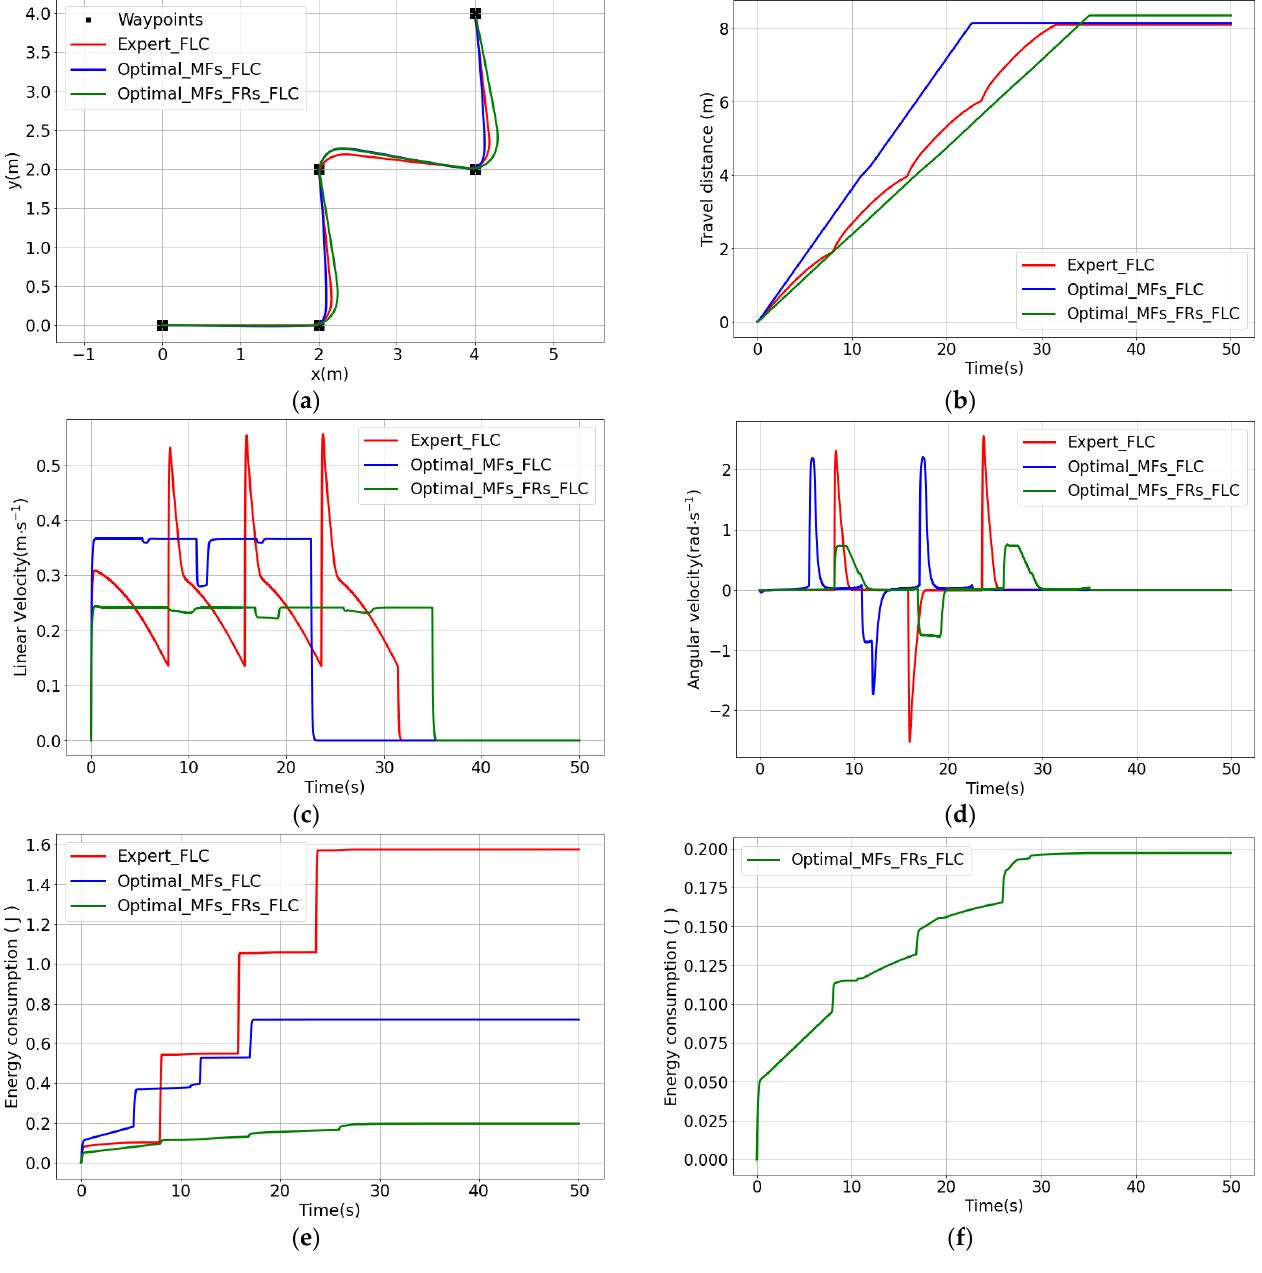
Figure 15. The simulation results in the case of using the zigzag path. ( a ) The trajectory of the robot; ( b ) The robot’s travel distance over time; ( c ) The robot’s linear velocity over time; ( d ) The robot’s angular velocity over time; ( e ) The robot’s kinetic energy loss over time; and ( f ) The zoom of the robot’s kinetic energy loss over time. Table 15. The kinetic energy loss and the travel distance of the robot when the robot tracks the zigzag path by the different controllers.